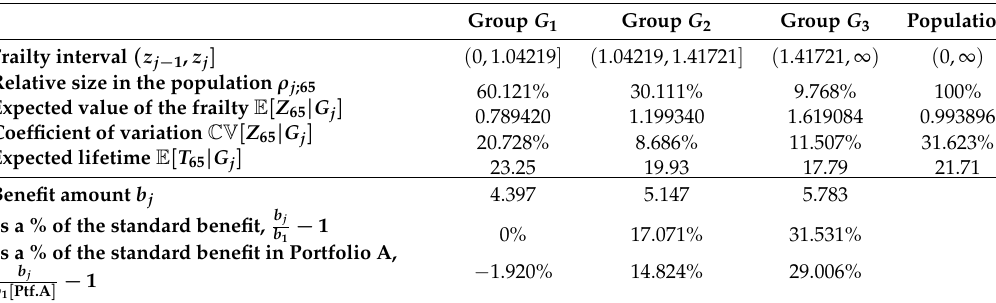
Table 16. Portfolio I: tariff structure and benefit amounts.